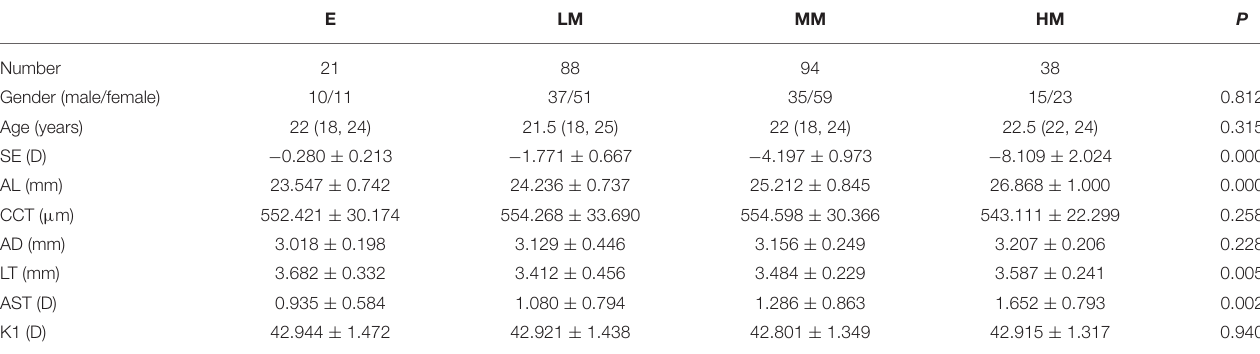
TABLE 1 | Biometric data of four refractive groups, M (Q25, Q75) or ¯ X ±